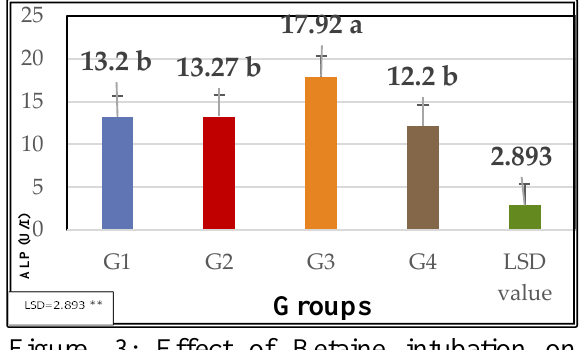
Figure, 3: Effect of Betaine intubation on alkaline phosphatase (ALP) Activity in experimental group.